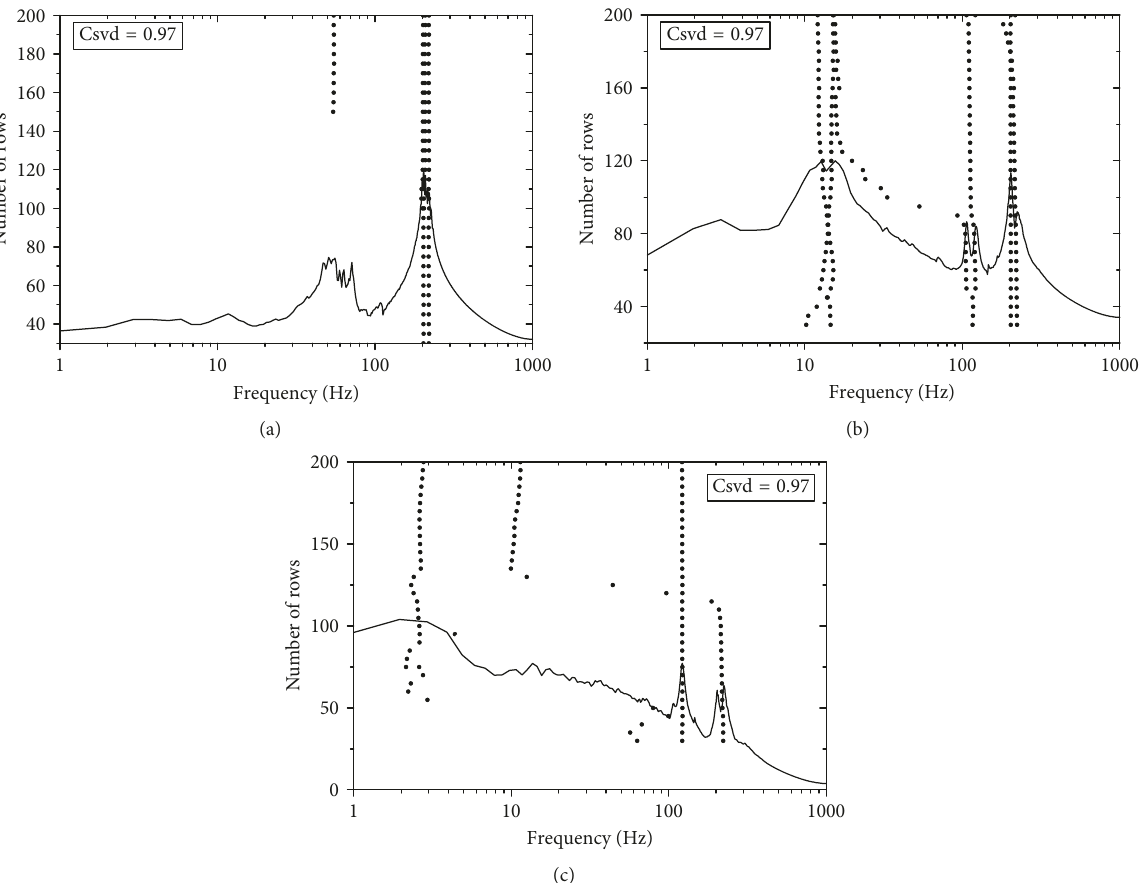
Figure 8: The stability diagrams of the response by applying impulse along different directions at the power tunnel: (a) radical; (b) longitudinal; (c) tangential directions.